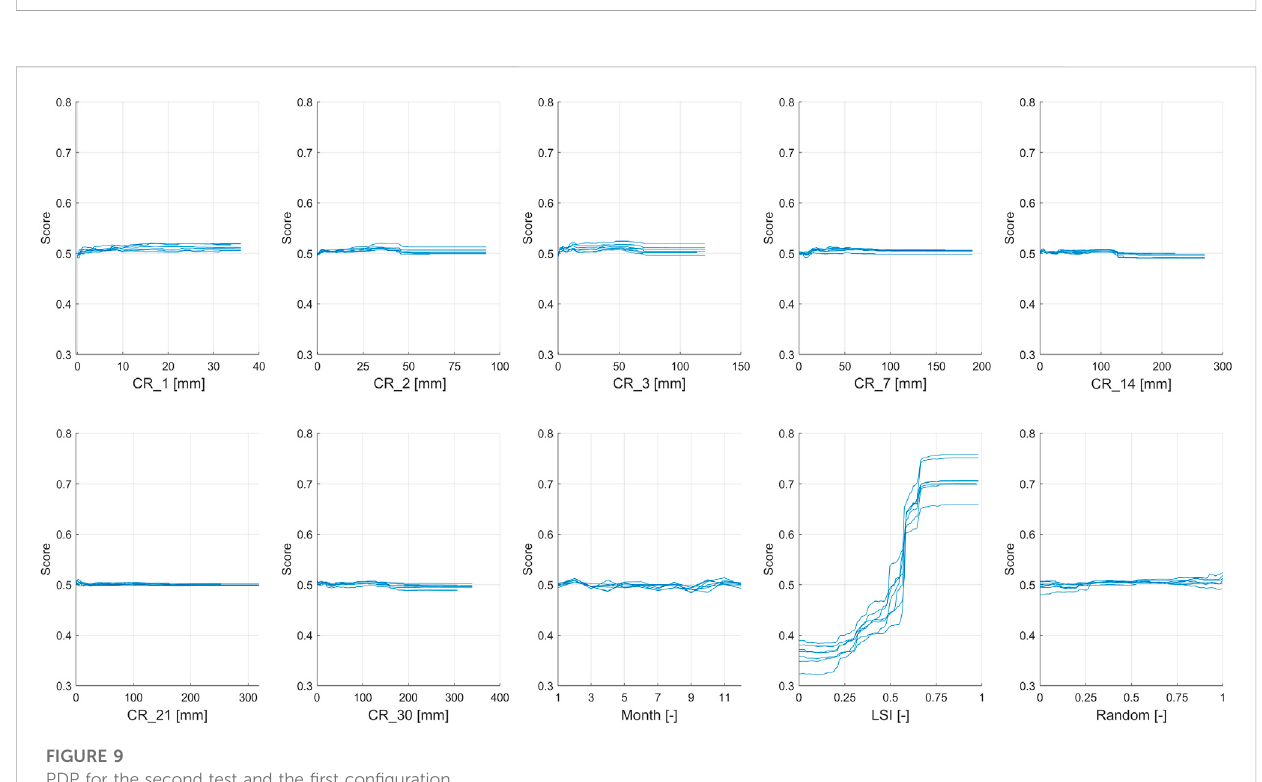
FIGURE 9 PDP for the second test and the fi rst con fi